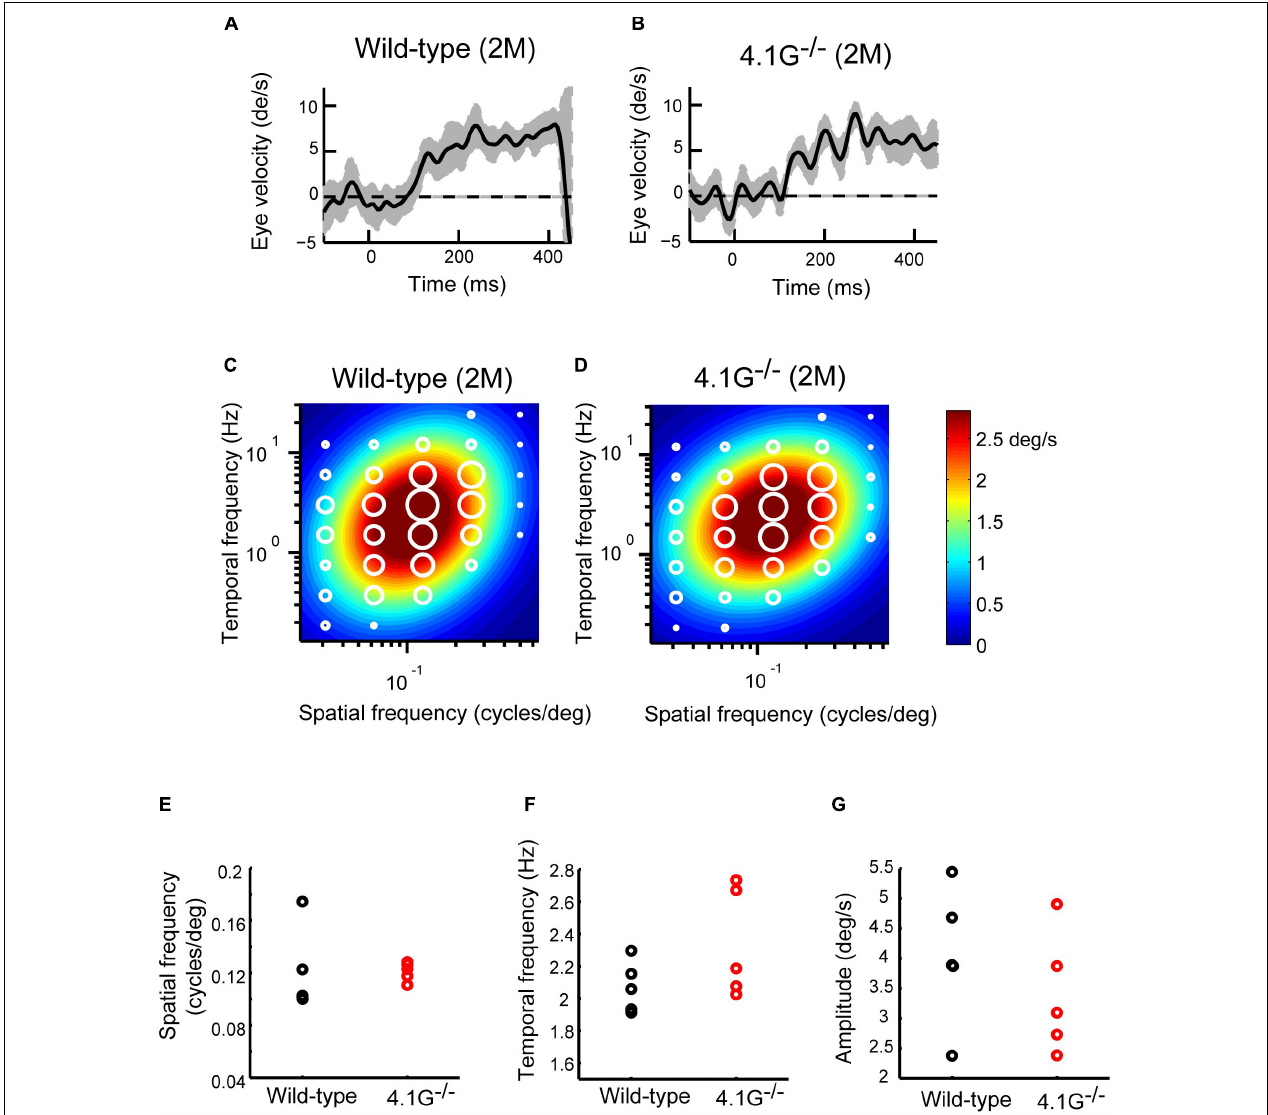
FIGURE 8 | Initial OKRs in young adult 4.1G - / - mice. (A,B) Eye velocity profiles obtained from wild-type control mouse (A) and 4.1G - / - mouse (B) . The eye movements evoked by the visual stimuli of SF = 0.125 cycles/deg; TF = 1.5 Hz. The gray shaded areas show the standard deviation of the individual eye velocity (A: 24 trials, B: 18 trials). (C) Heat maps of the initial OKRs in young adult wild-type control mice (2–3 months old, n = 5) and (D) young adult 4.1G - / - mice (2–3 months old, n = 5). Amplitudes of the initial OKRs represented by the diameter of the white circles are plotted in the coordinate system of SF and TF. Heat maps show the best-fit Gaussian functions. (E–G) Comparisons of the properties of the initial OKRs. The difference in the optimal SF (E) , optimal TF (F) , and peak amplitudes of the responses (G) are shown in individual plots (black dots: wild-type, red dots: 4.1G - / -